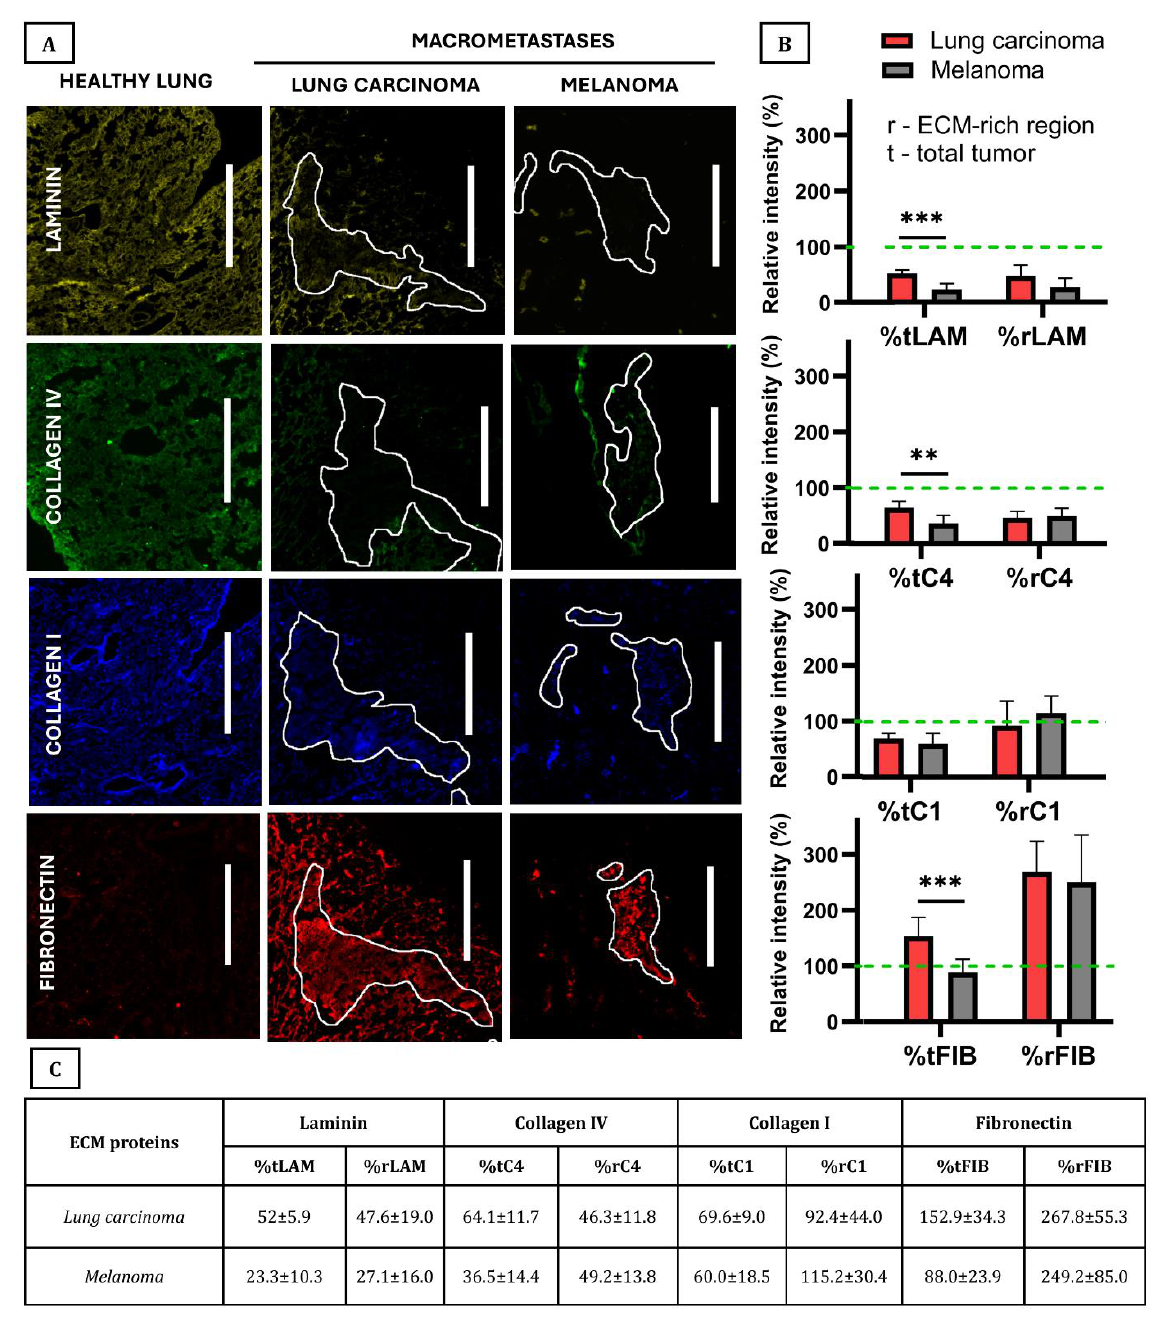
Figure 4. ECM protein staining and quantification of CAR and MEL macrometastases. ( A ) Representative fluorescent images of acellular tumor sections (20 μm) after immunostaining of laminin (yellow), collagen IV (green), collagen I (blue), and fibronectin (red). Healthy lung ECM is represented in the left column. ECM-rich areas (%r, white selections) were traced using a phase contrast image and then applied to the corresponding fluorescent image. ( B , C ) ECM proteins’ fluorescent signal quantification of the total tumor (%t) and tumor ECM-rich areas (%r). Healthy lung ECM signal was normalized to 100% (green line). Statistical analysis was performed using unpaired parametric student’s t -tests (**, p -value < 0.01, ***, p -value < 0.001). If nothing else is indicated, the relationship between two variables was found to be insignificant ( p > 0.05). Scale bar = 500 μm.